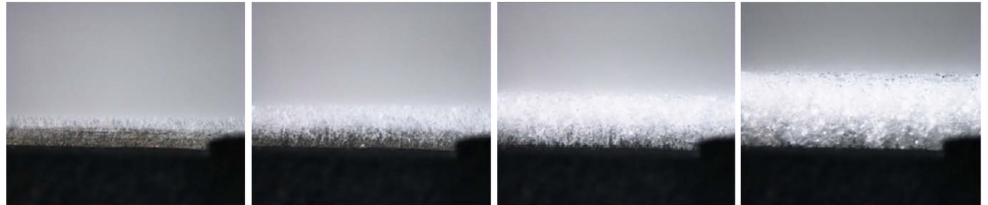
Figure 10. Snapshots of the frost formation process as a function of time for an airstream velocity of 0.7 m/s, air temperature of 16 ◦ C, relative humidity of 50%, and a plate temperature of − 18 ◦ C [8].